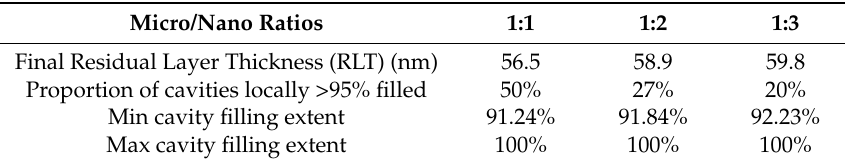
Table 1. Chip-scale imprint results for various micro/nano